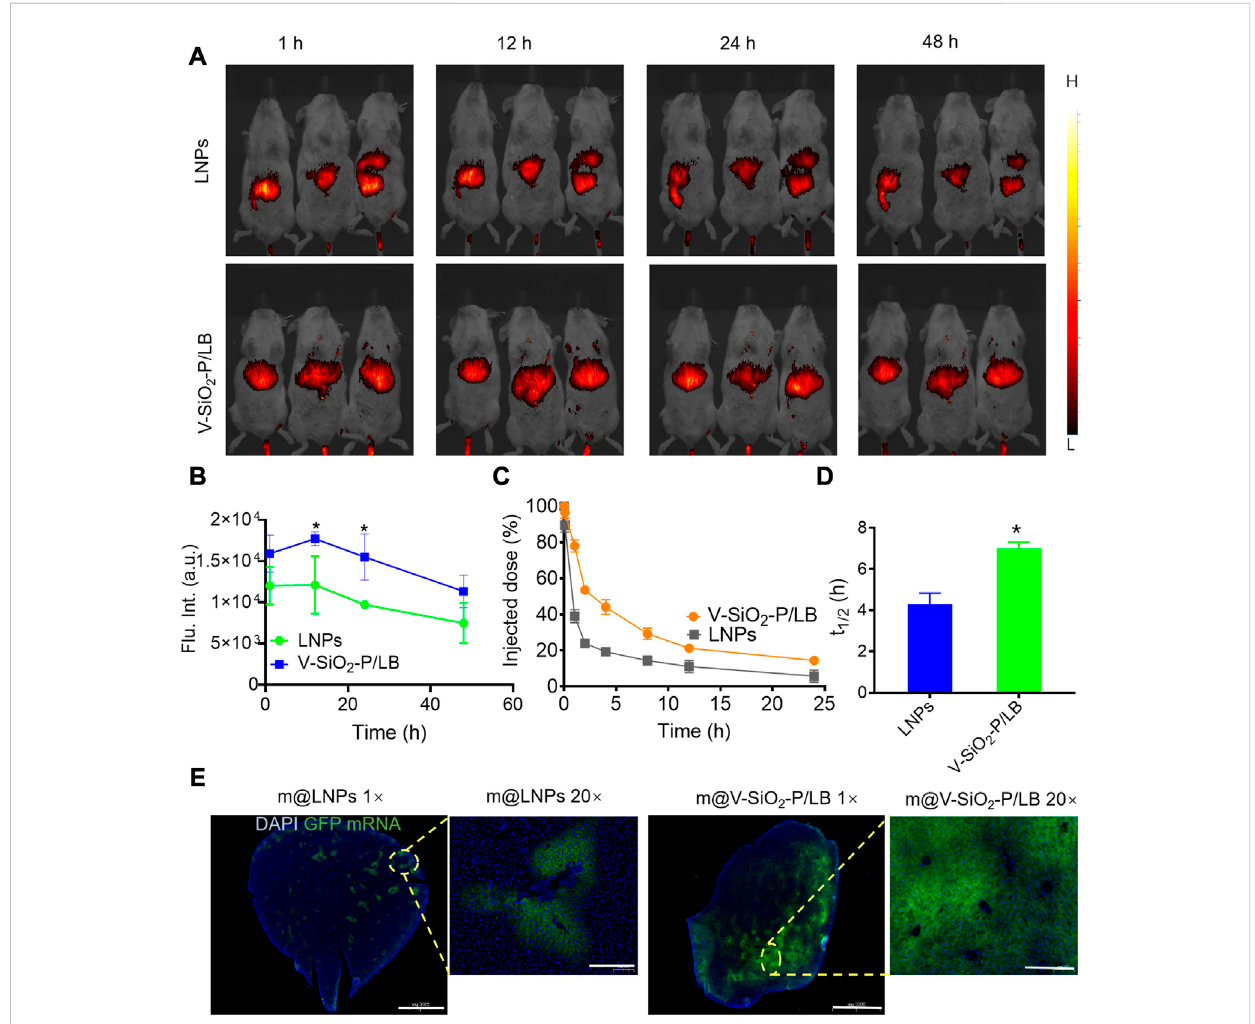
FIGURE 4 V-SiO 2 -P/LBnanoparticlescontributetoprecisemRNAdeliverytotheliver invivo .(A) Bioluminescenceanalysesat1h,12h,24h,48hand72 hin BALB/cmice(n=3micepergroup) injected (I) .v.withICG-labelledLNPsorV-SiO 2 -P/LBnanoparticles. (B) Quanti fi cationoflightintensity overtime. (C) Time-dependent blood levels of ICG-labelled LNPs and V-SiO 2 -P/LB nanoparticles after tail vein injection,calculated as thepercentage of injected dose remaining intheblood. (D) Bloodcirculation half-lives (t 1/2 )ofLNPsand V-SiO 2 -P/LB nanoparticles(n =3mice pergroup).* p < 0.05. (E) GFPmRNA expression levels in liver tissue after m@LNPs or m@v-SiO2-P/LB treatment under different magni fi